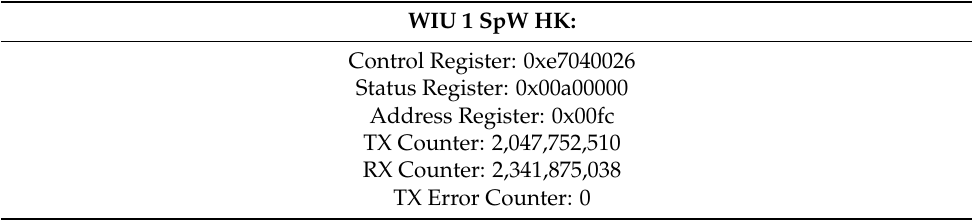
Table 7. Received SpW Housekeeping Data from WIU Gateway.